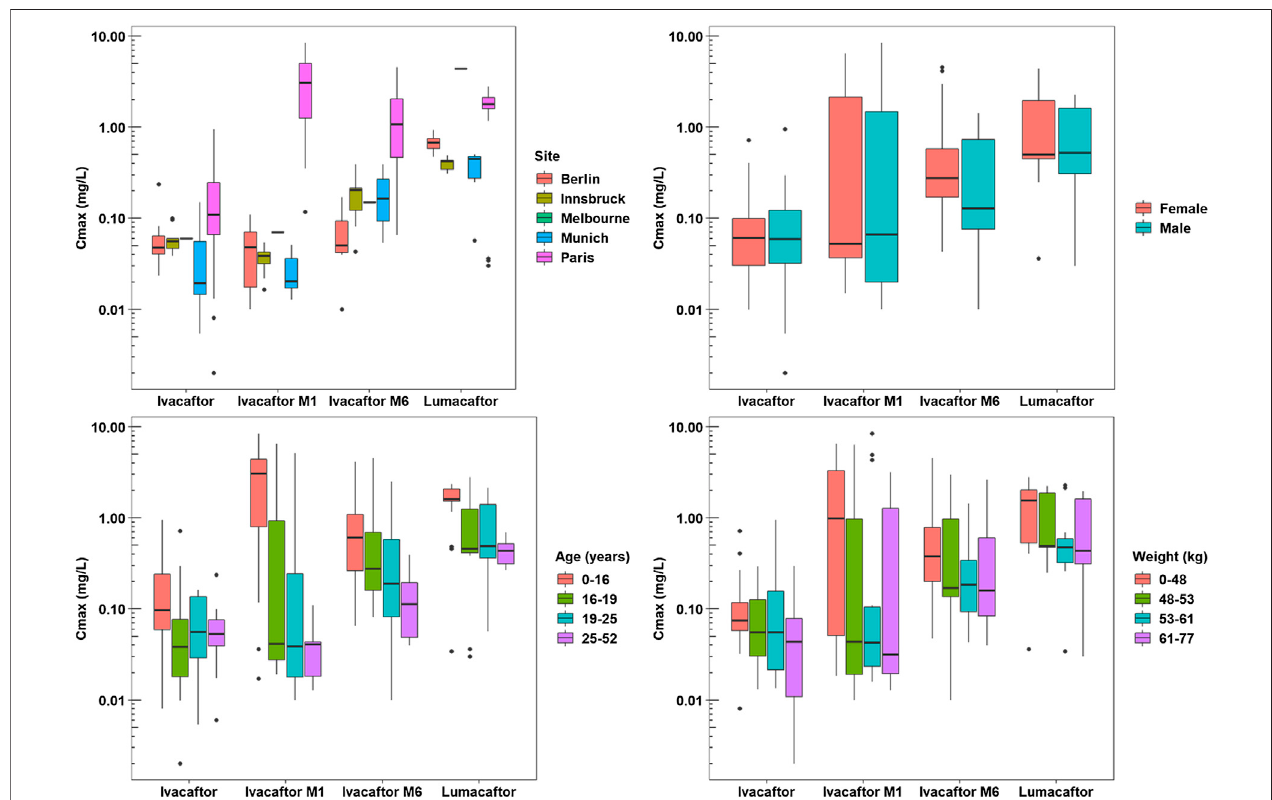
FIGURE 3 | Pharmacokinetic Analysis Plots - C max